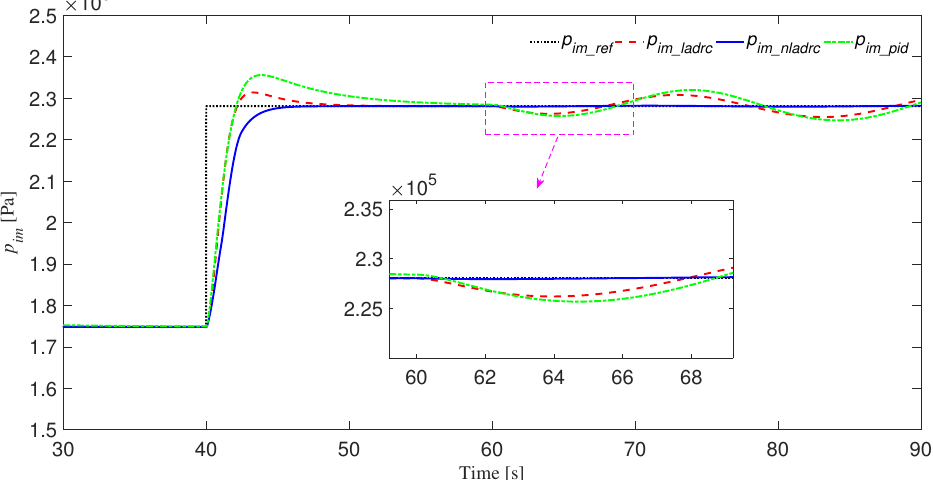
Figure 9. Response curve of intake manifold pressure p im after adding sinusoidal control